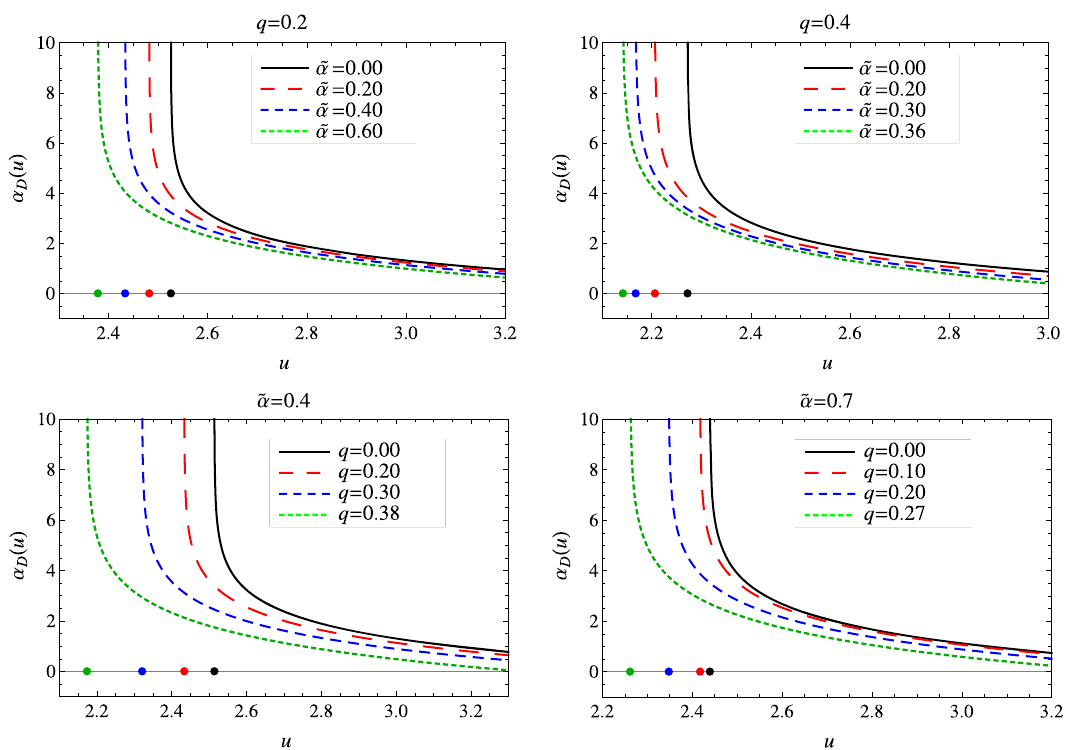
Fig. 7 Plot showing the variation of deflection as a functions impact parameter u for different values of ˜ α and q . The points on the horizontal axis correspond to the impact parameter u = u m at which deflection angle diverges